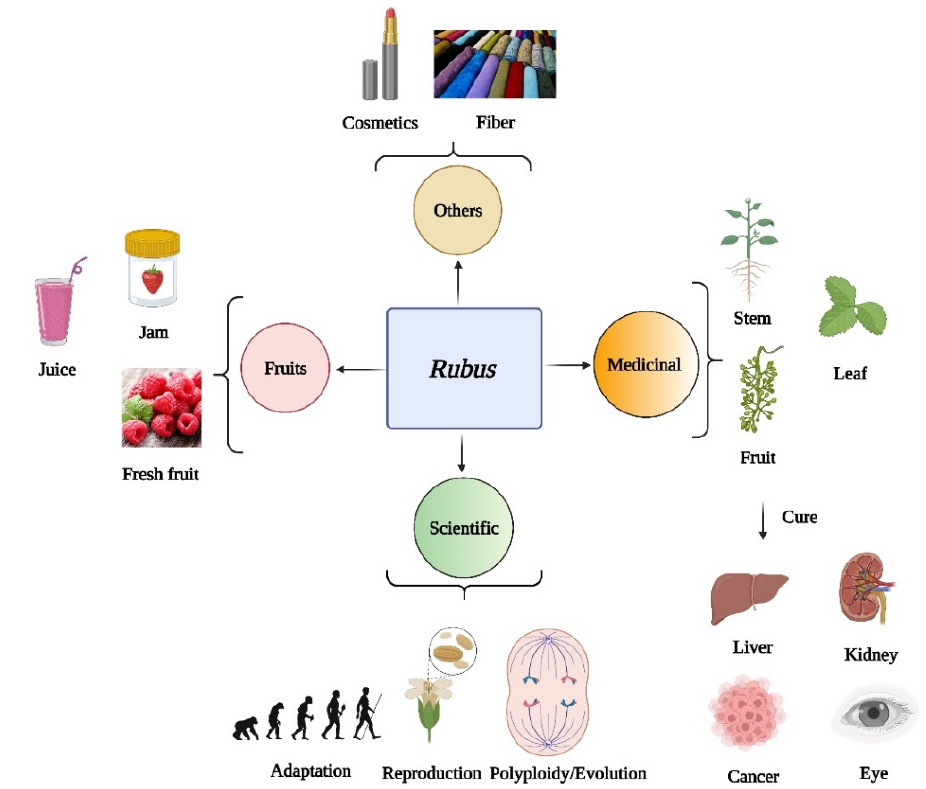
Figure 1. Different aspects of Rubus species utilization. The attributes of Rubus are primarily utilized for applications involving fruit (fresh fruit, jam, and juice), medicinal compounds (fruit, leaf, and stem), and scientific studies (adaptation, reproduction, polyploidy, and evolution). In addition, among the wild Rubus species, some can also be used to produce cosmetics or fiber products. This figure was created using BioRender software.